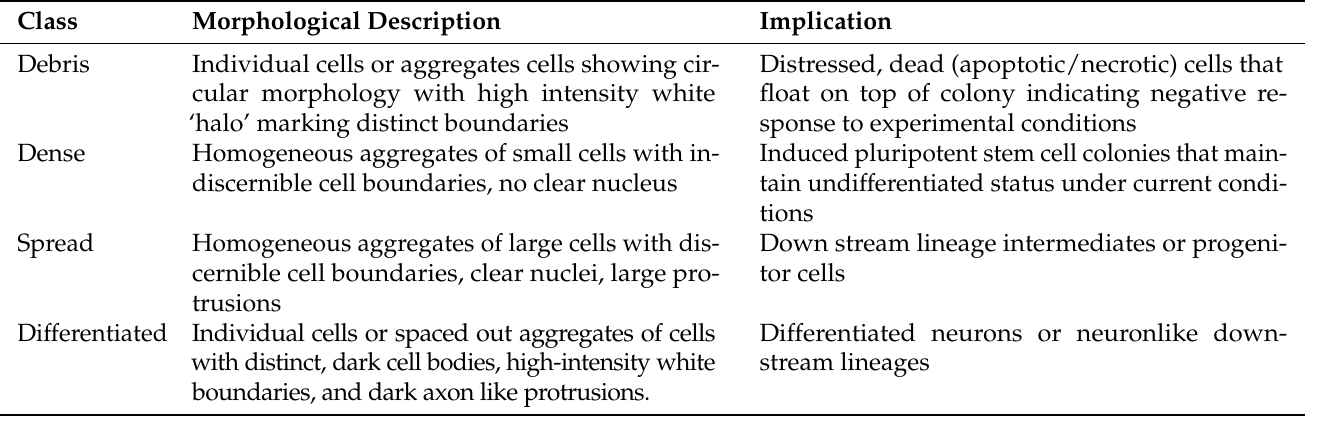
Table 1. Morphological class descriptions and corresponding biological